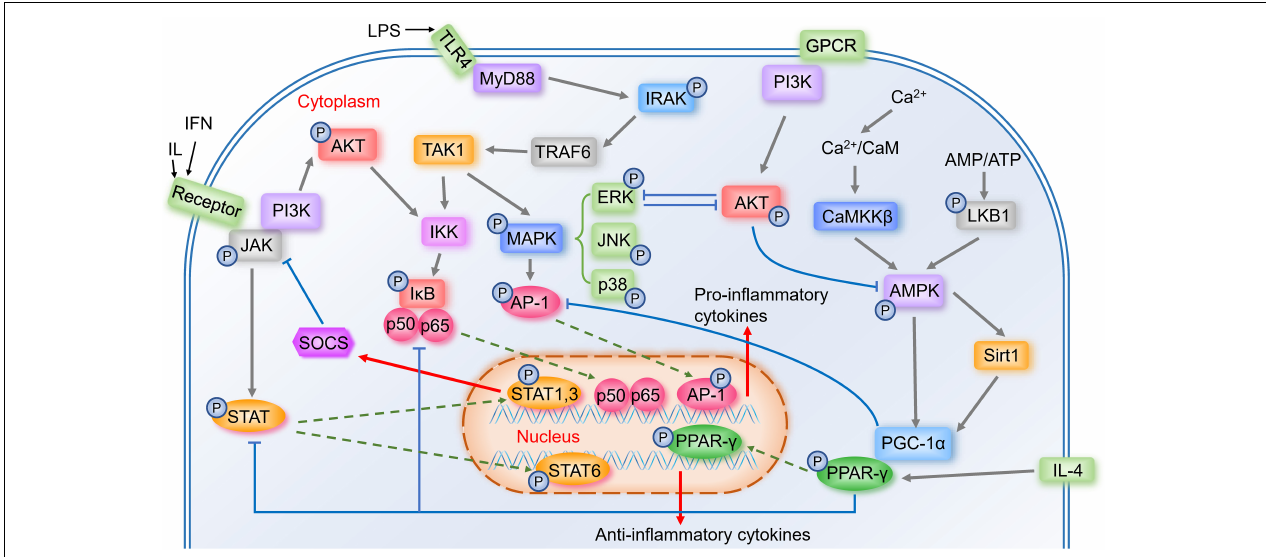
FIGURE 1 | Important signal pathways in the modulation of microglia polarization. Activated TLR4 associates with MyD88 to induce the autophosphorylation of IRAK, which interacts with TRAF6. TRAF6 then activates the TAK1, activating two major pro-inflammatory pathways, IKK/I κ B/NF- κ B and MAPK (including ERK, JNK, p38)/AP-1 signaling pathways, thus the pro-inflammatory genes transcribe. Activated JAK induces the phosphorylation of STAT, and STAT1&STAT3 induce expression of pro-inflammatory mediators and negative feedback regulator SOCS. While STAT6 is involved in microglial M2 polarization. Calcium/CaMKK β /AMPK signaling pathway is activated by Ca 2 + /CaM or LKB1, the latter is activated by increased AMP/ATP ratio. AMPK activates Sirt1, leading to the activation of PGC-1 α , while AMPK also phosphorylates PGC-1 α directly. PGC-1 α interacts with PPAR- γ , which is involved in IL-4-induced M2 polarization. PPAR- γ antagonizes AP-1, NF- κ B, and STAT1. GPCR and phosphorylated JAK could activate PI3K/AKT pathway. AKT prevents AMPK activation, and ERK and AKT inhibit each